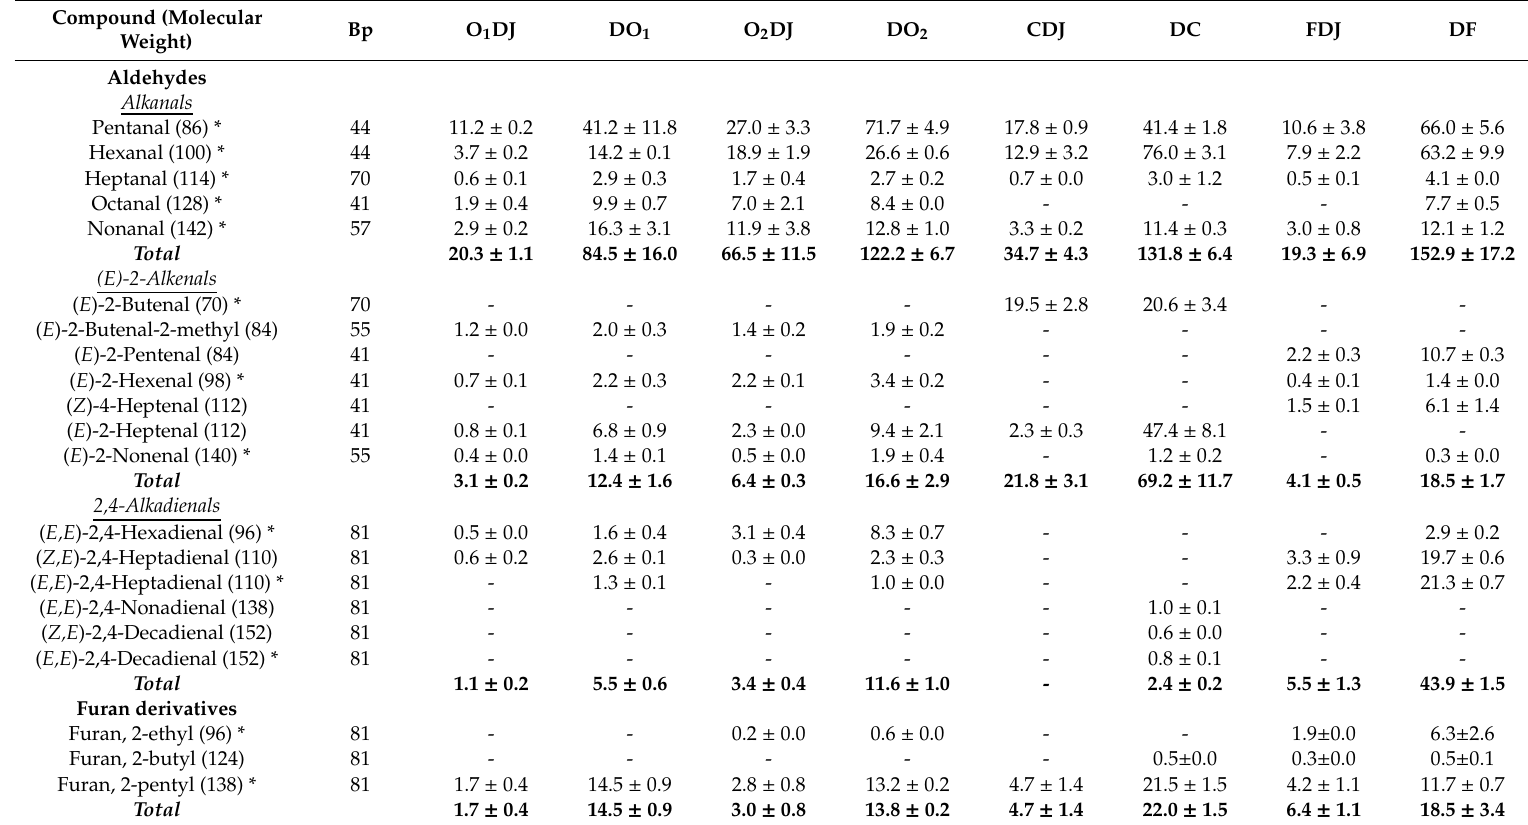
Table 4. Abundances of some oxidation markers extracted and identified by SPME-GC / MS in the headspace of mixture of digestive juices and olive oils, corn oil and virgin flaxseed oil (O 1 DJ, O 2 DJ, CDJ and FDJ) and in the digestate of these oils (DO 1 , DO 2 , DC and DF). Data are expressed as area counts of the mass spectra base peak (Bp) of each compound multiplied by 10 − 6 , and obtained as average of two determinations together with their standard deviations. Data of corn and virgin flaxseed oils were taken from previous studies